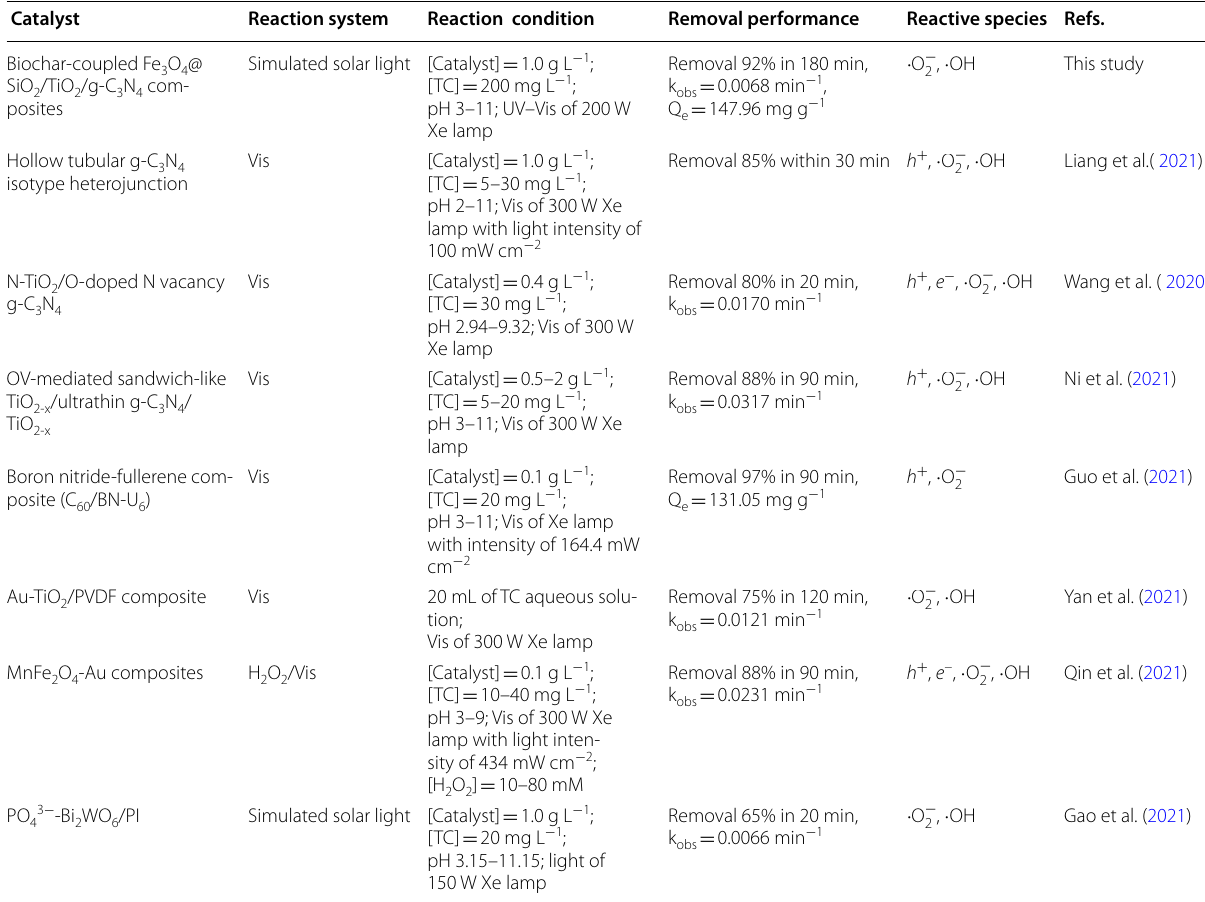
Table 2 Comparison of photocatalytic removal of various catalysts for tetracycline degradation